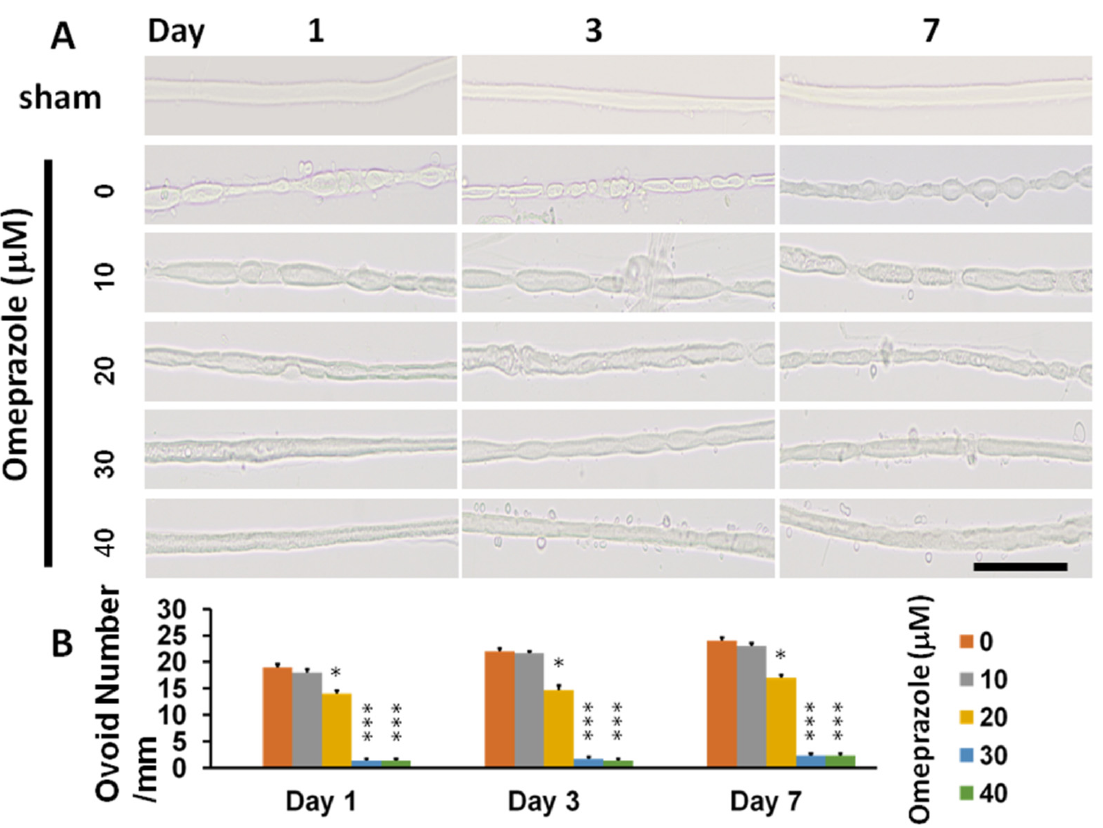
Figure 1. Assessment of AhR agonist (omeprazole) in preventing nerve degeneration in the nerve explant culture. The main trunk of the sciatic nerve was harvested from C57BL/6J mice with an age of one week and resected to 3 mm in length for culture. The nerve explant culture was subjected to different dosages of omeprazole and the ovoid numbers were calculated at the different time profiles to assess the protective effect. ( A ) The illustration of ovoid formation in different concentrations of omeprazole observed at different time points. ( B ) The quantitative analysis of ovoid number in the different treatment groups and time points. N = 3, Bar length = 100 µ m; *: p < 0.05; ***: p < 0.001.